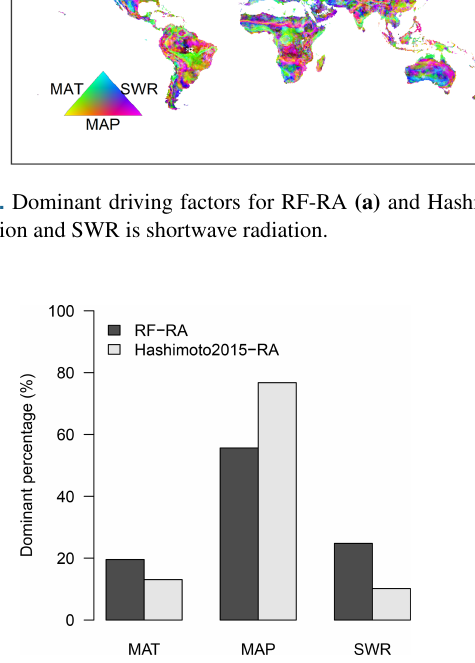
Figure 10. The percentage of land (calculated from cell areas) dom- inated by mean annual temperature (MAT), precipitation (MAP) and shortwave radiation (SWR) for RF-RA and Hashimoto2015-